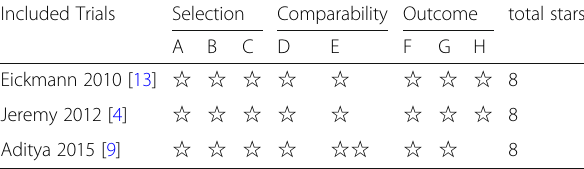
Table 2 Risk of Bias Evaluation for the Retroactive Study (NOS) Included